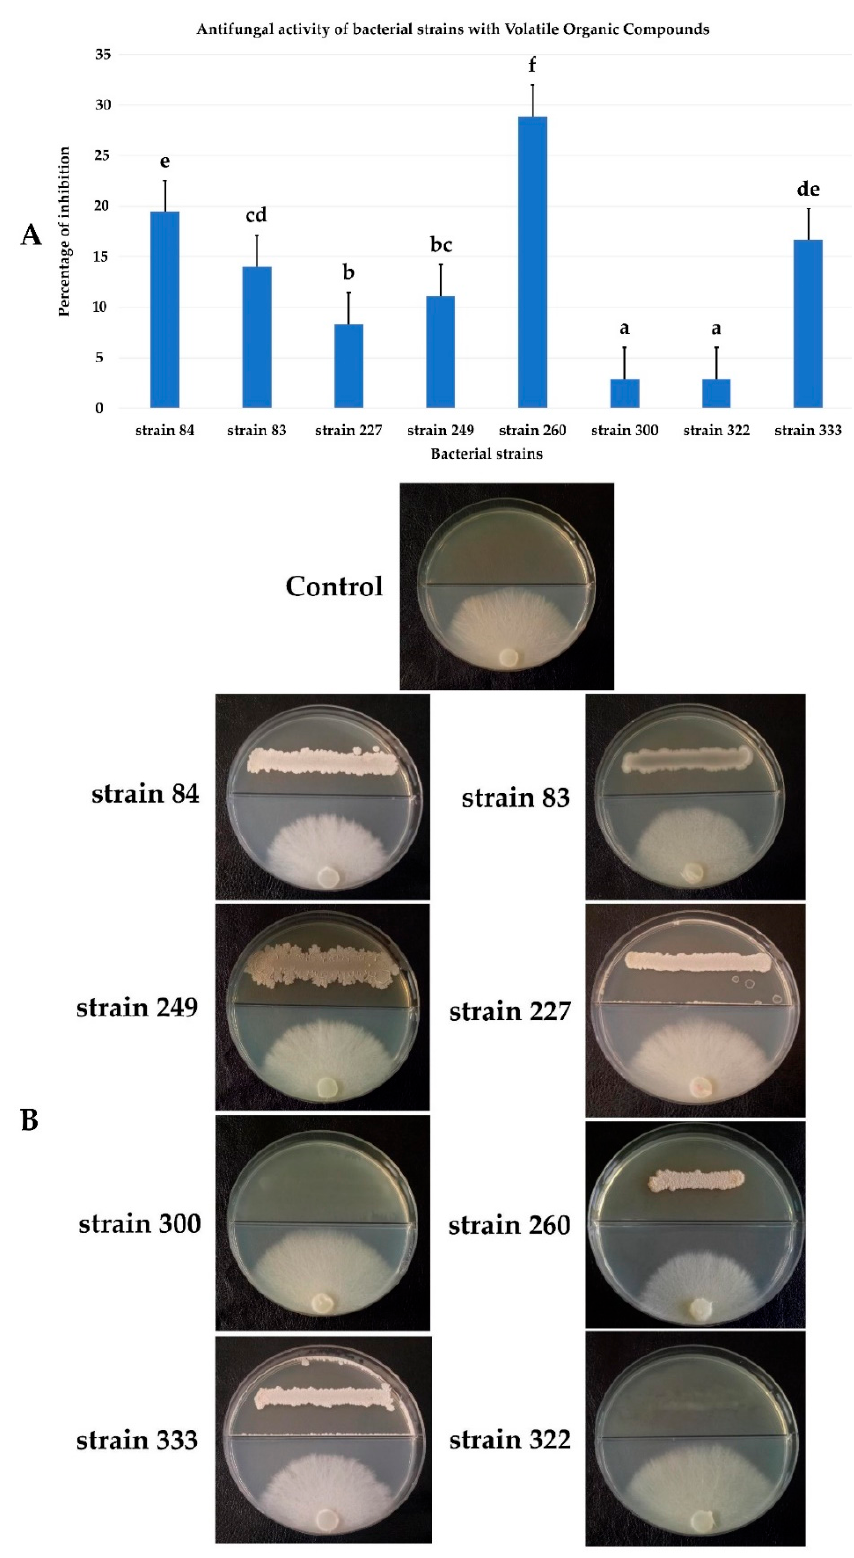
Figure 8. ( A ) Percentage of inhibition of VOCs produced by bacterial strains towards FOA1. The data present the means ± the standard error. Different letters between bars in each group indicate a significant difference at ( p < 0.05) determined by ANOVA with the comparison of means using Tukey’s HSD. ( B ) The in vitro antifungal effect of the VOCs produced by the bacterial strains on the mycelial growth of the